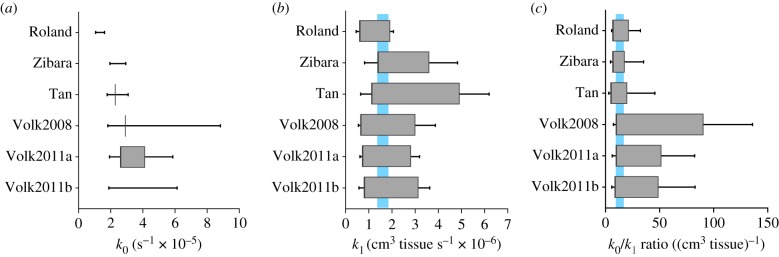
Range of parameter and threshold values. In each of the six cases, values of k1,thresh and ratiothresh
­­­were found among all of the randomly generated values of k1 or the k0/k1 ratio used in the simulations. (a) k0, (b) k1 and (c) k0/k1 ratio. Bars: the ranges of all generated parameter values in each case. Boxes: the ranges of possible threshold values in each case. Shading: the common range of threshold values among the six cases. (Online version in colour.)